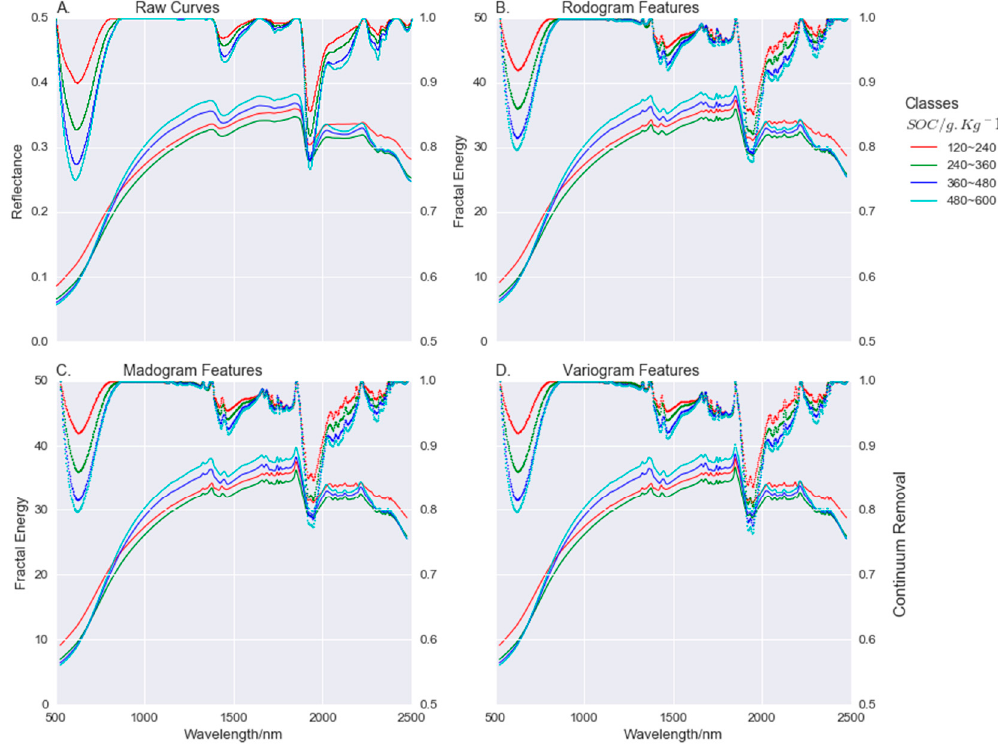
Figure 4. ( A ) Average spectral reflectance and continuum removal reflectance of LUCAS organic soil samples computed by SOC classes. ( B – D ) Average fractal energy and continuum removal responses of organic soil samples computed by SOC classes using rodogram, madogram and variogram estimators respectively. The central wavelength number of the corresponding spectral segment is assigned to the fractal feature.